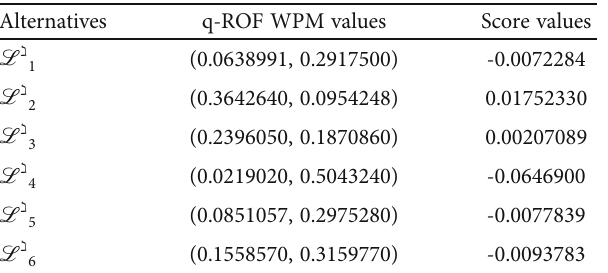
Table 7: Total relative importance and score